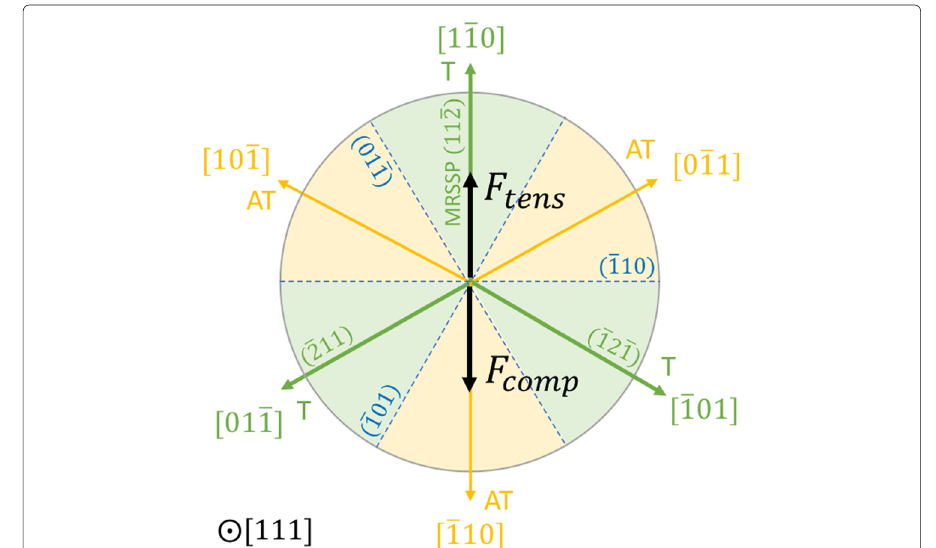
Fig. 2 Crystallographic directions and planes relevant for the motion of 1 [111] dislocations. The 1 [111] 2 2 zonal vector is pointing out towards the viewer. The arrows show directions of the Peach-Koehler (PK) force [111] dislocation under compression ( F comp ) and tension ( F tens ) along the acting on a right-hand screw 1 2 [001] axis. In both cases the PK force is parallel to the vertical ( 11 ¯ 2) slip plane, referred to as the maximum resolved shear stress plane (MRSSP)